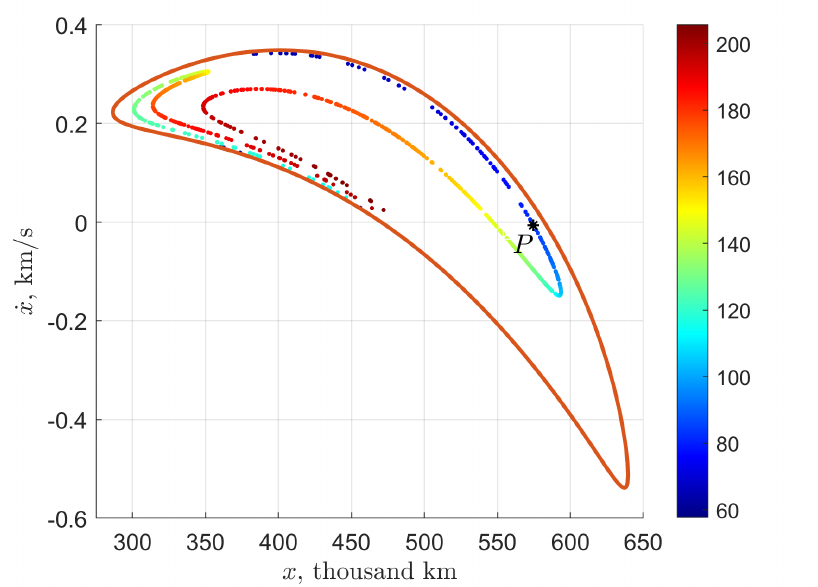
Figure 9. L 2 lunar gateway for J = 3.06 with the r π = 3141 km perilune distance contour line marked. Targeting point P results in the trajectory shown in Figure 6 (the argument of perilune ω π = 83.5